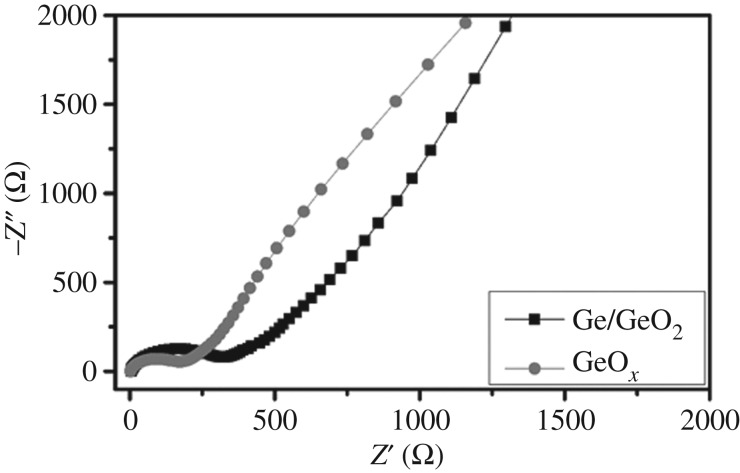
The Nyquist plots of amorphous GeOx and GeO2/Ge electrodes.